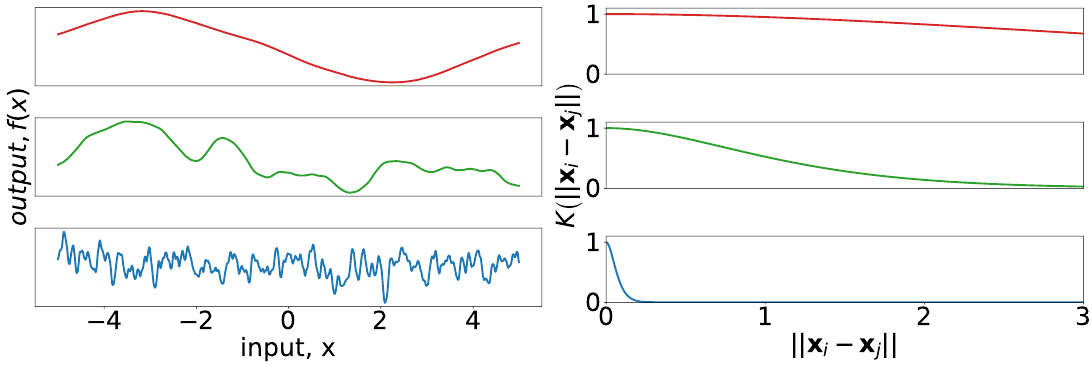
Figure 6. ( left ) Random draws from Gaussian processes with covariances defined by three different Matérn 5/2 kernels. In all cases, the amplitude is 1. The length-scales are 2, 1, 0.25 for top, middle, and bottom, respectively. ( right ) Covariance kernels corresponding to the cases on the